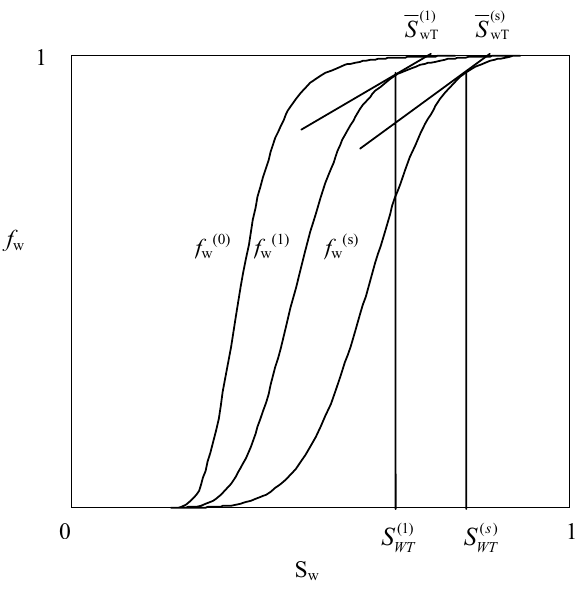
Fig. 1 Fractional flow